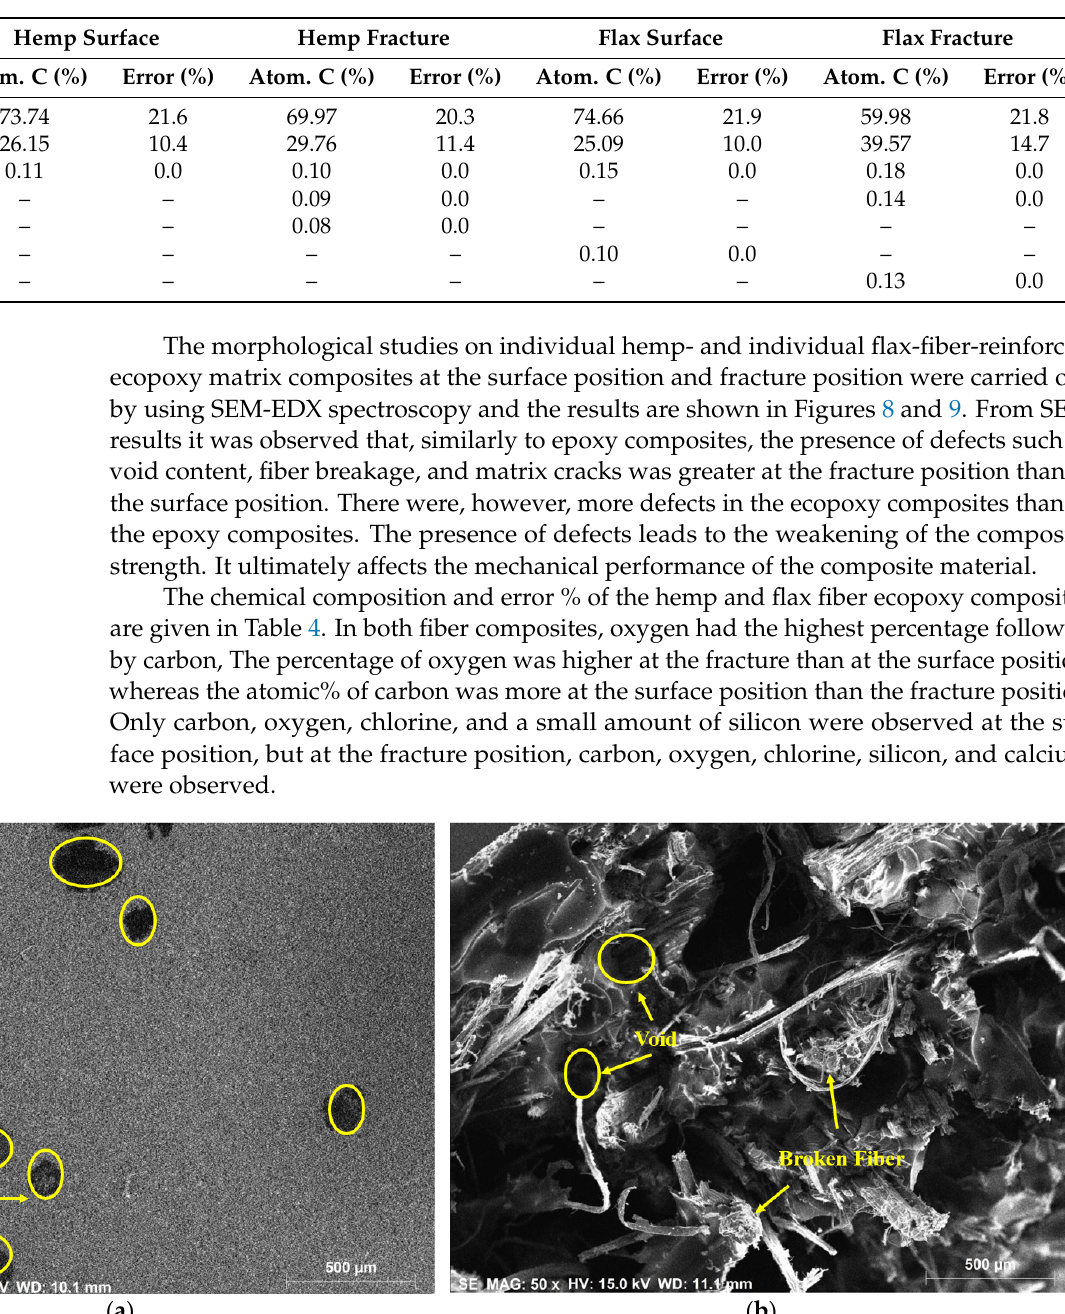
Table 3. Chemical composition of hemp and flax fiber epoxy composites.